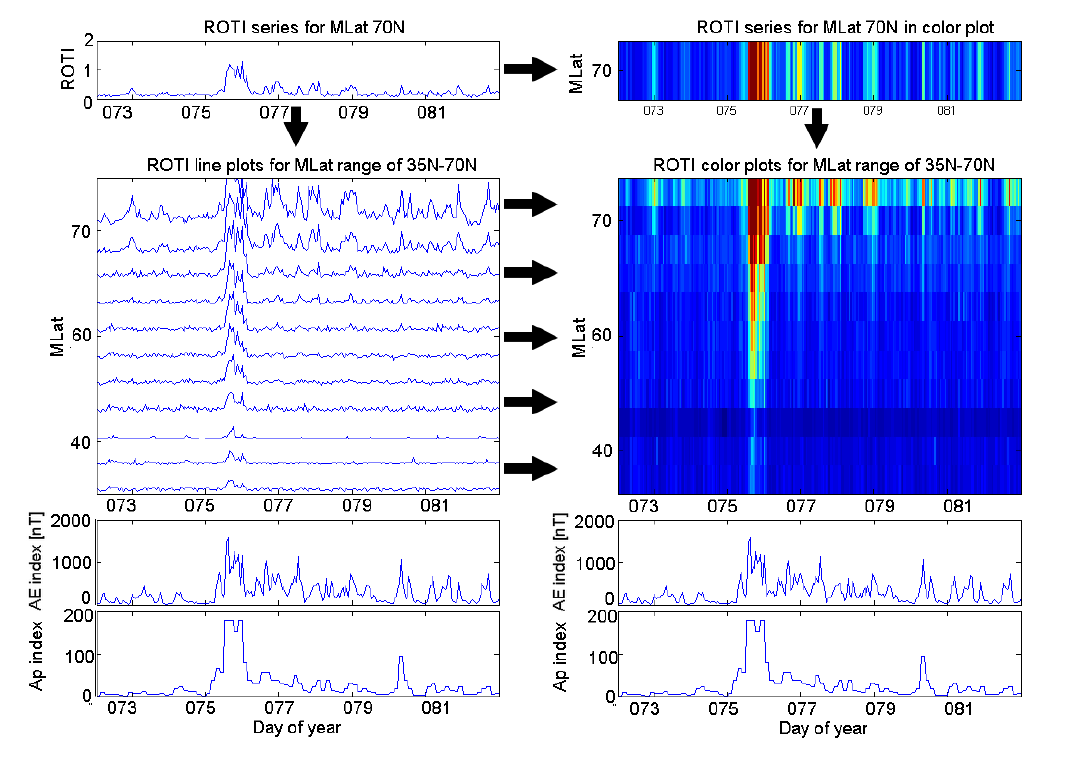
Figure 4. An example for ROTI series reorganization into a keogram-like color plot set together with corresponding Ap and AE values. Days 72–83 of